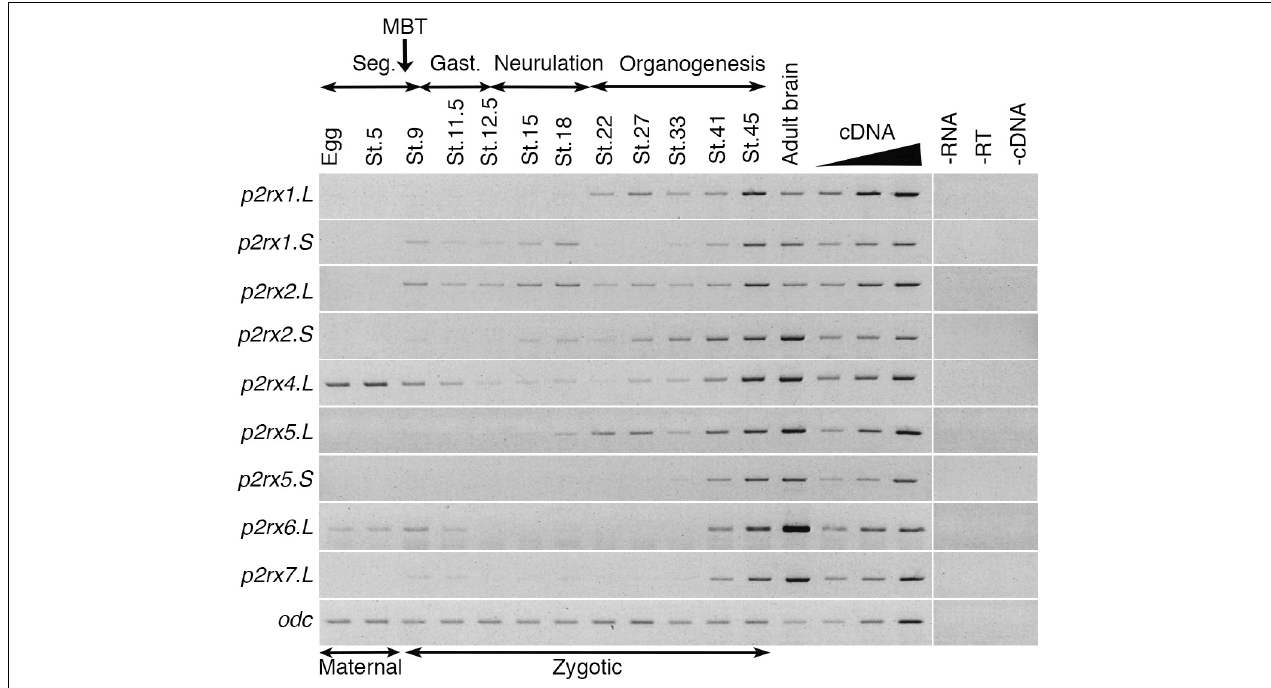
FIGURE 2 | Temporal expression profile of p2rx genes during embryogenesis. RT-PCR analysis showing the expression pattern of p2rx subunits in X. laevis unfertilized egg and embryos at different stages (St.). Adult brain cDNA was used as positive control and three negative controls (-RT, -RNA, -cDNA) were also performed. The linearity of the signal was controlled by carrying out PCR reactions on doubling dilutions of cDNA from stage 45 embryo, illustrated by the triangle. Odc ( ornithine decarboxylase ) was used as a loading control. The different phases of embryogenesis and the Mid-Blastula transition (MBT), the switch between maternal and zygotic expression, are indicated above the different embryonic stages. Seg, segmentation; Gast, Gastrulation.